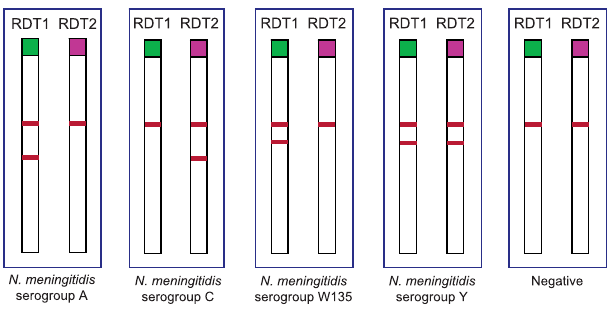
Figure 1. RDT Results by